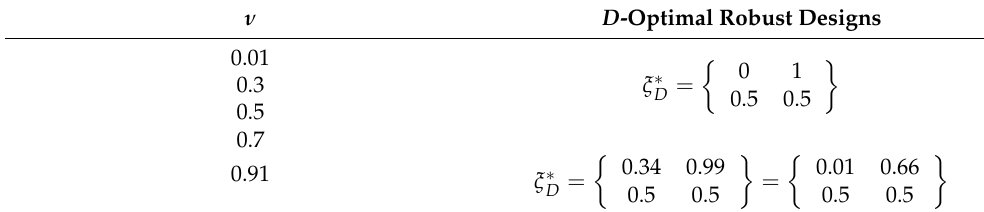
Table 1. 2-point D -optimal robust designs computed for the log-logistic model.